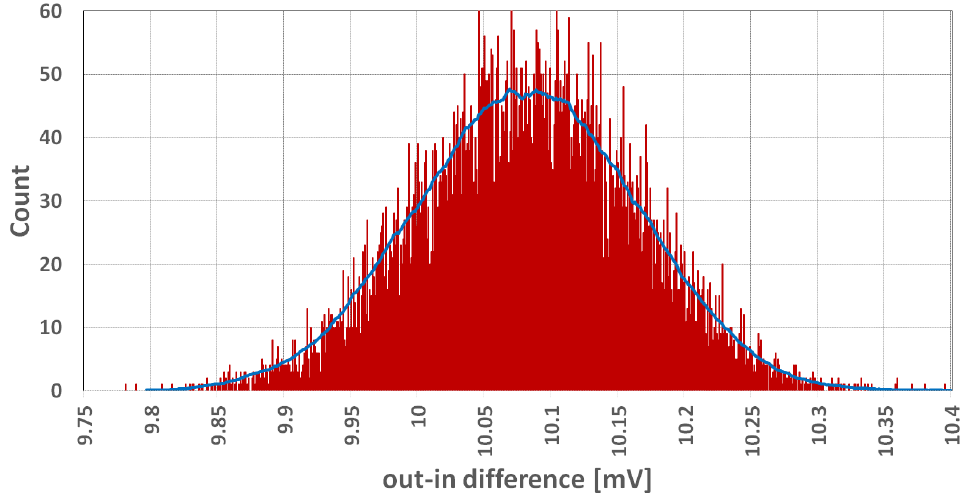
Figure 18. Readout distribution for the layout-based simulation of the SOAC variant of the buffer (with safety devices).